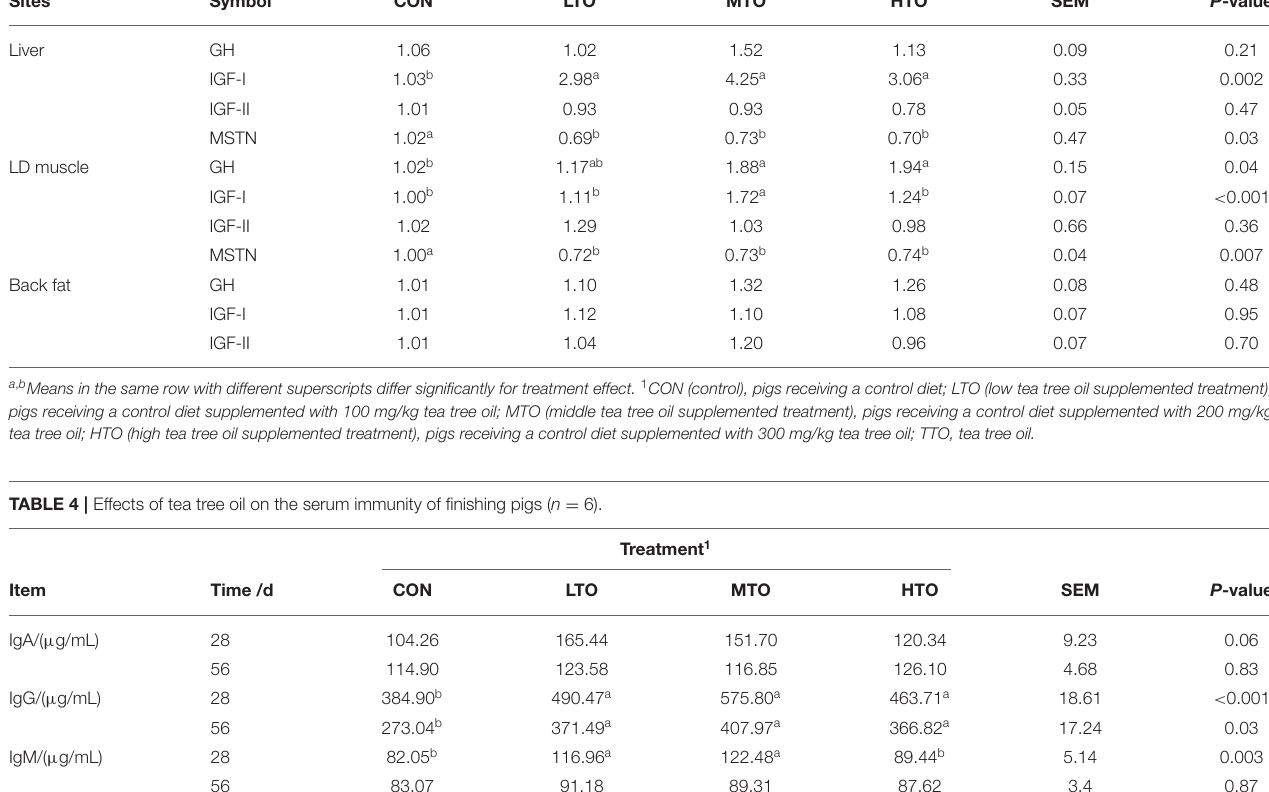
TABLE 3 | Effect of TTO on the genes expression of GH, IGF-I, IGF-II, and MSTN of finishing pigs ( n = 6). Sites